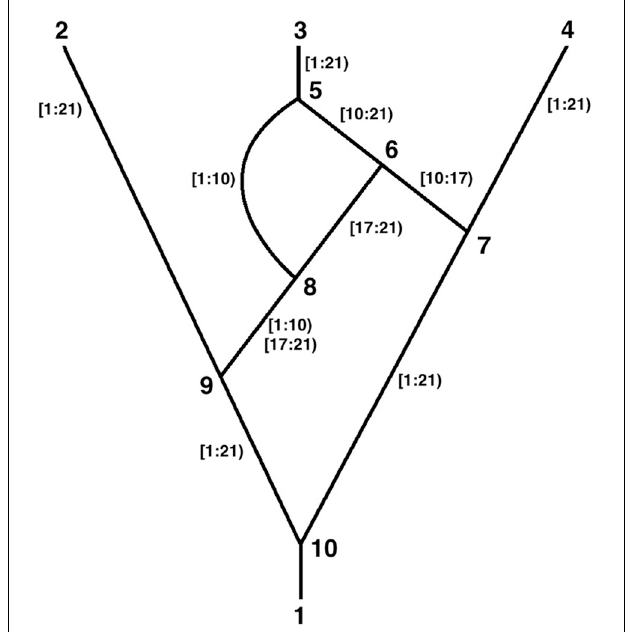
FIGURE 1 | A recombinant